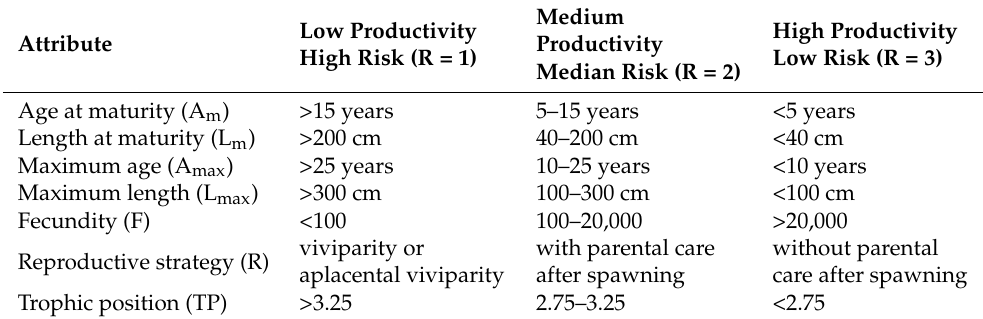
Table 2. Productivity cutoff scores for species attributes for the ERA method, and the attribute values into low, medium and high productivity categories.